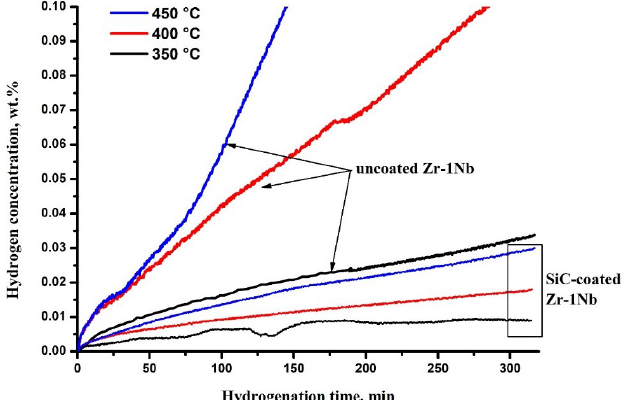
Figure 3. Hydrogen sorption kinetic curves.